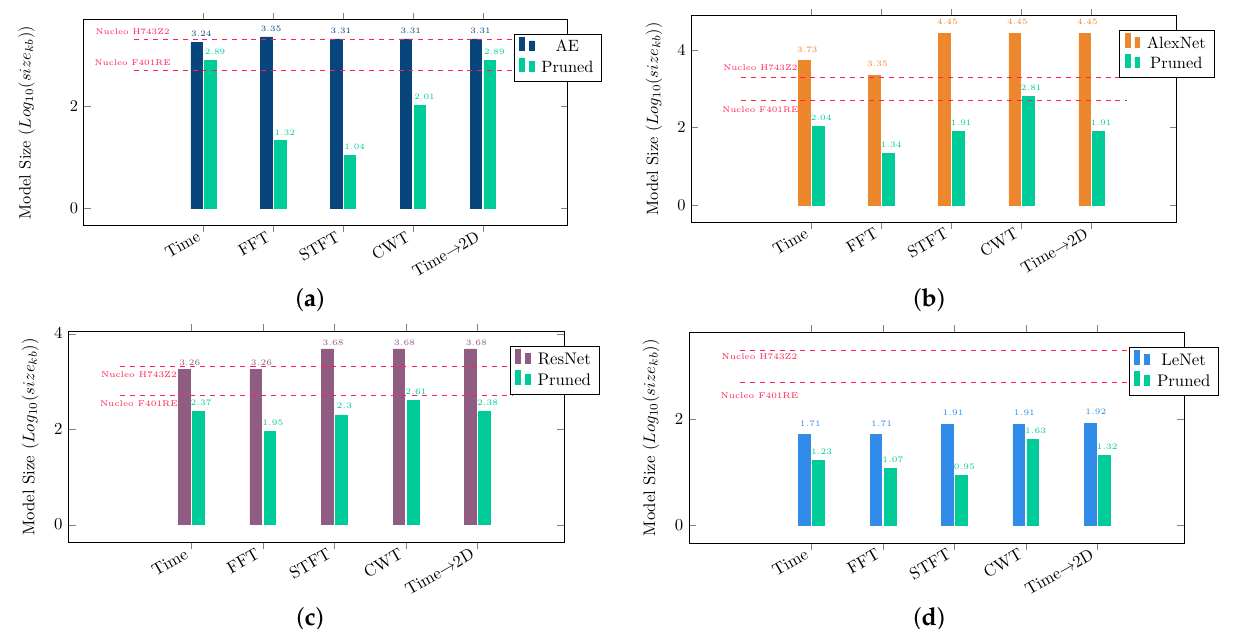
Figure 11. Comparison of size of AE, AlexNet, ResNet and LeNet for different feature sets with pruned model sizes. ( a ) Comparison of model size between benchmark and pruned AE model for different features; ( b ) Comparison of model size between benchmark and pruned AlexNet model for different features; ( c ) Comparison of model size between benchmark and pruned ResNet model for different features; ( d ) Comparison of model size between bench mark and pruned LeNet model for different